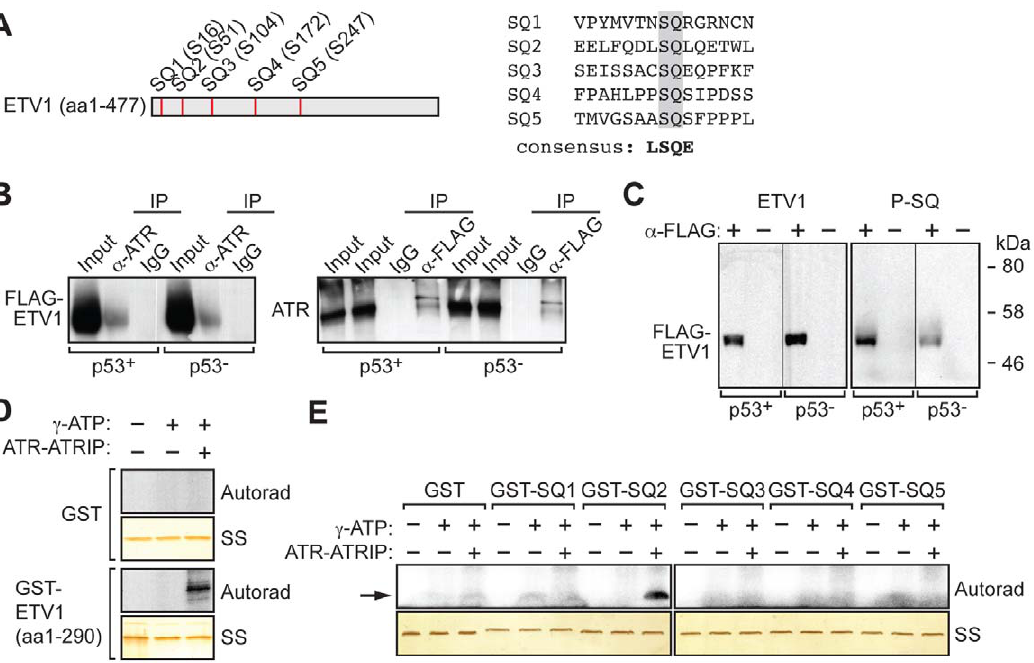
Figure 6. ATR interacts with and phosphorylates ETV1. (A) (Left) Schematic of the full-length ETV protein, showing the positions of the five potential ATR phosphorylation sites (SQ). (Right) Sequence surrounding each potential phosphorylation site, and the consensus ATR phosphorylation site. (B) Co-immunoprecipitation assay. Cell extract from p53 + or p53 2 HCT116 cells expressing FLAG-ETV1 was immunoprecipitated using an ATR antibody and the immunoprecipitate analyzed by immunoblotting for FLAG (left), or immunoprecipitated using a FLAG antibody and the immunoprecipitate analyzed by immunoblotting for ATR (right). IgG was used as a specificity control. (C) Extract from p53 + or p53 2 HCT116 cells expressing FLAG-ETV1 was immunoprecipitated using a FLAG antibody and the immunoprecipitate analyzed by immunoblotting using an antibody that recognizes ETV1 or a phosphorylated SQ motif (P-SQ). (D) In vitro kinase assay monitoring the ability of ATR to phosphorylate a GST-ETV1 (amino acids 1–290) fusion protein containing all five potential SQ phosphorylation sites or, as a control, GST alone. Autoradiographic images (Autorad, top) and corresponding silver-stained gels (SS, bottom) are shown. (E) In vitro kinase assay monitoring the ability of ATR to phosphorylate a series of GST- ETV1 fusion proteins, each containing 15 amino acids encompassing a potential SQ phosphorylation site (sequences shown in A) or, as a control, GST alone. Autoradiographic images (Autorad, top) and corresponding silver-stained gels (SS, bottom) are shown. The position of the 32 P-labeled fusion protein is indicated by the